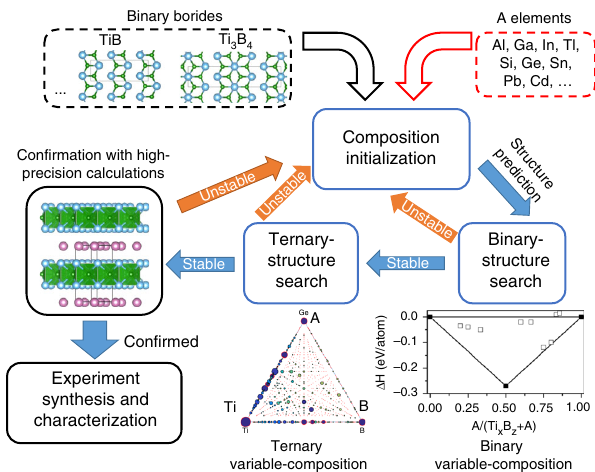
Fig. 1 Calculation-based approach to the discovery of novel boron- containing ternary phases. The silver blue, purple, and green spheres in the structure models indicate Ti, In, and B atoms,